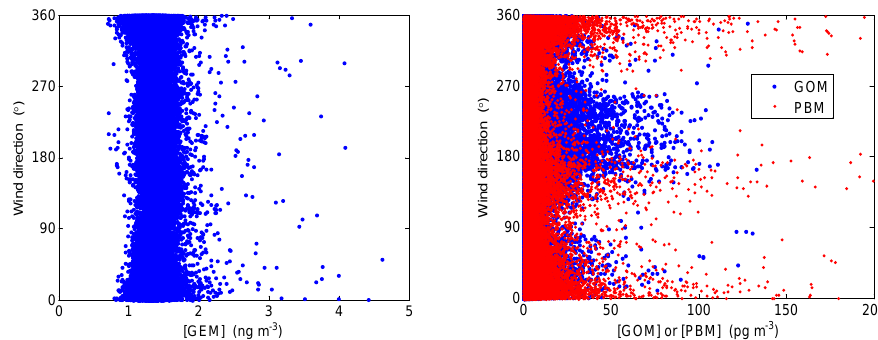
Figure 10. Relationships between wind direction and GEM ( top ) and between wind direction and GOM or PBM ( bottom ). Individual data points are hourly averaged measurements at the Grand Bay site from 2007 to 2018.